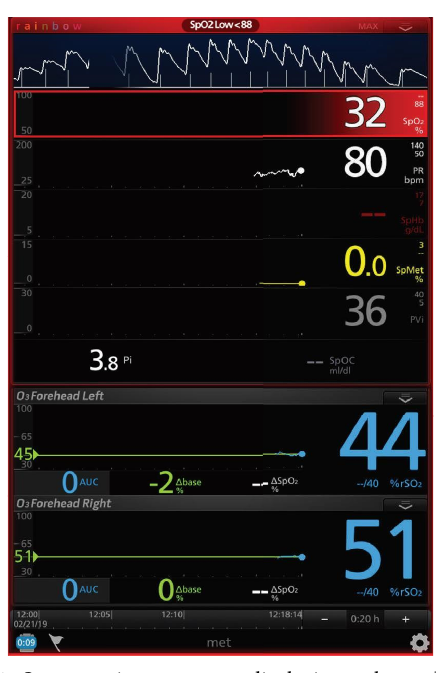
Figure 4: Our co-oximeter screen displaying pulse and cerebral oximetry